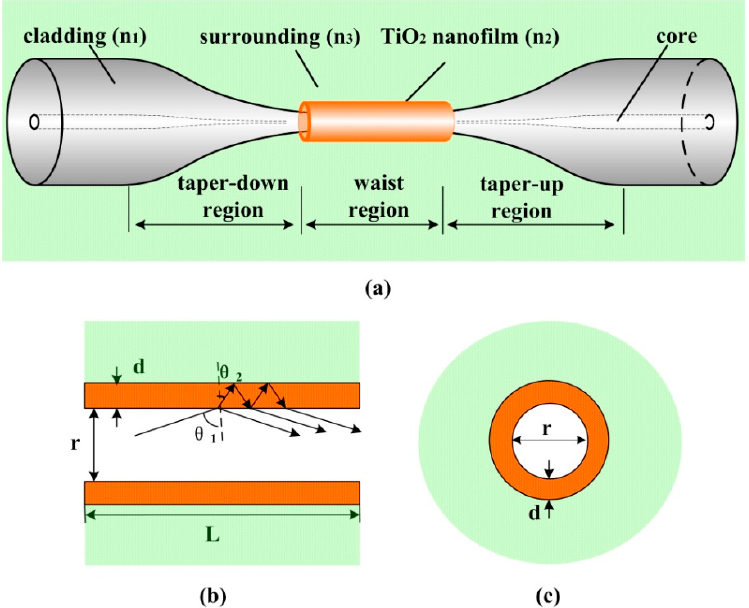
Figure 1. Schematic diagram of ( a ) the tapered fiber coated with TiO 2 nanofilm, and the coated region in the ( b ) axial and ( c ) radial directions.